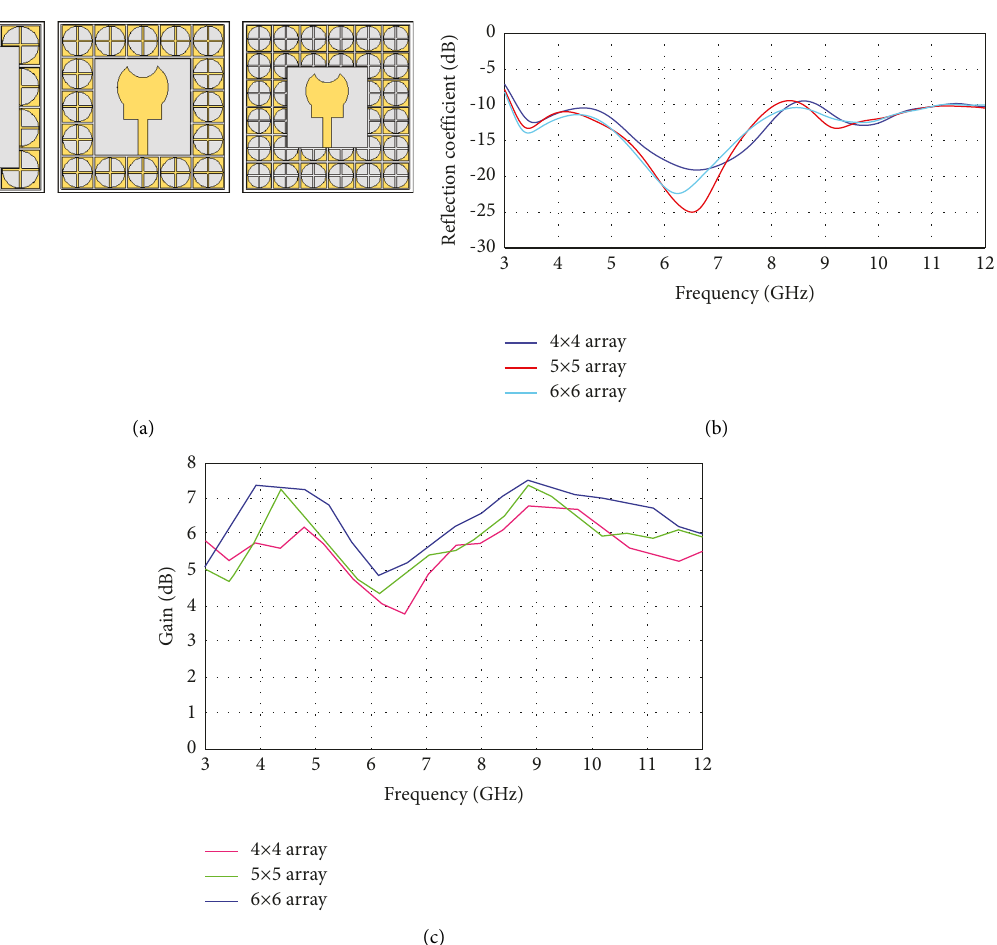
Figure 6: (a) FSS array configurations. (b) Reflection coefficient for FSS arrays. (c) Simulated antenna gain for FSS arrays.